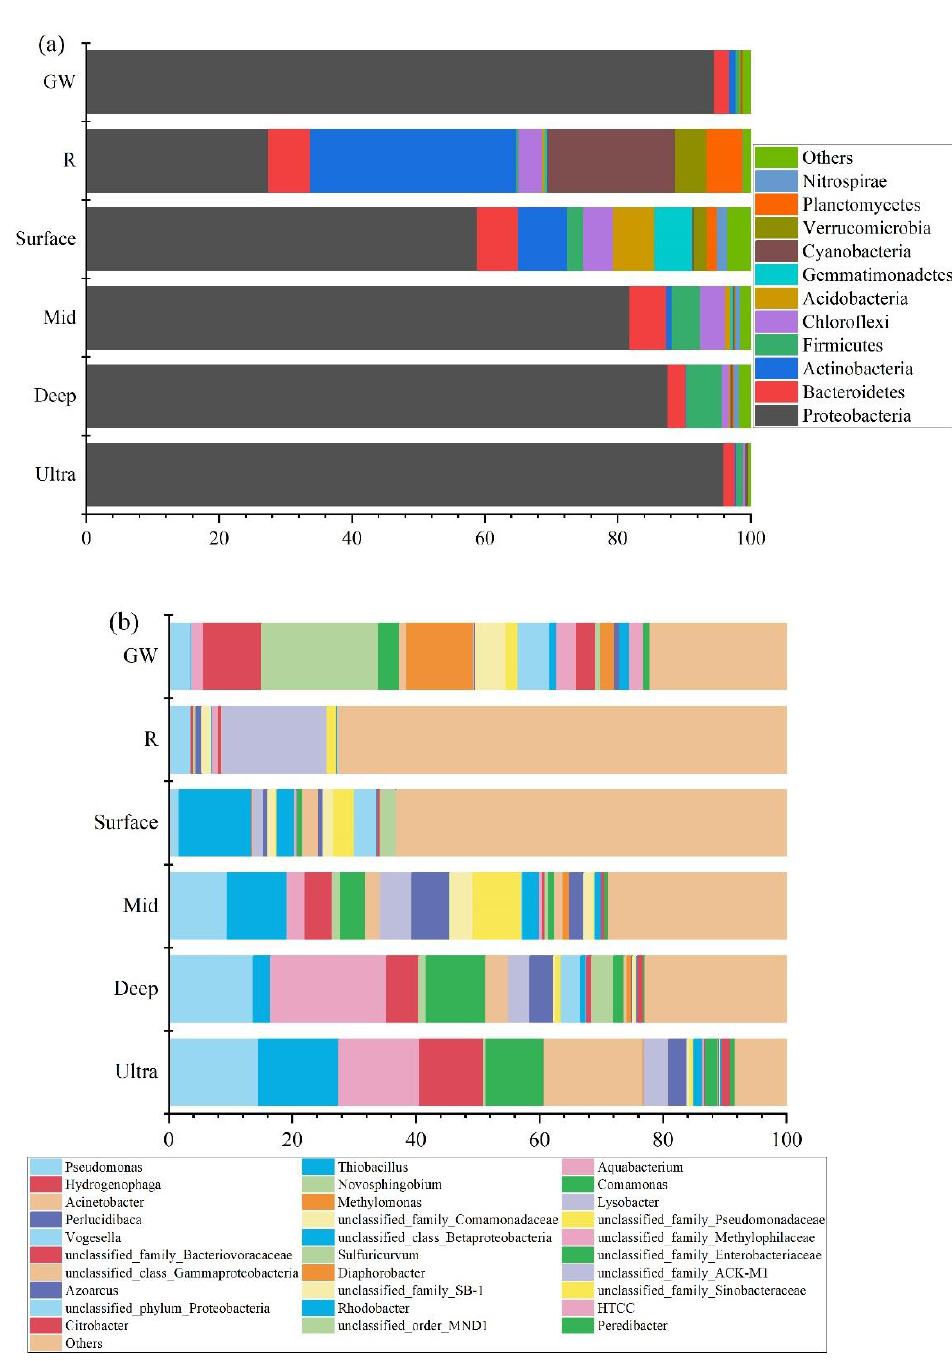
Figure 2. Bacterial community composition at ( a ) the phylum level and ( b ) genus level.